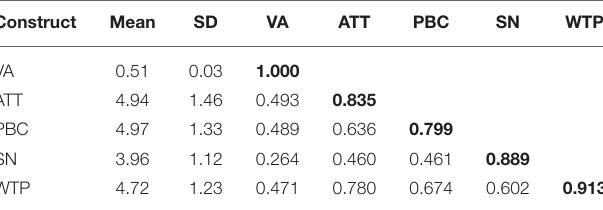
TABLE 3 | Discriminant validity.